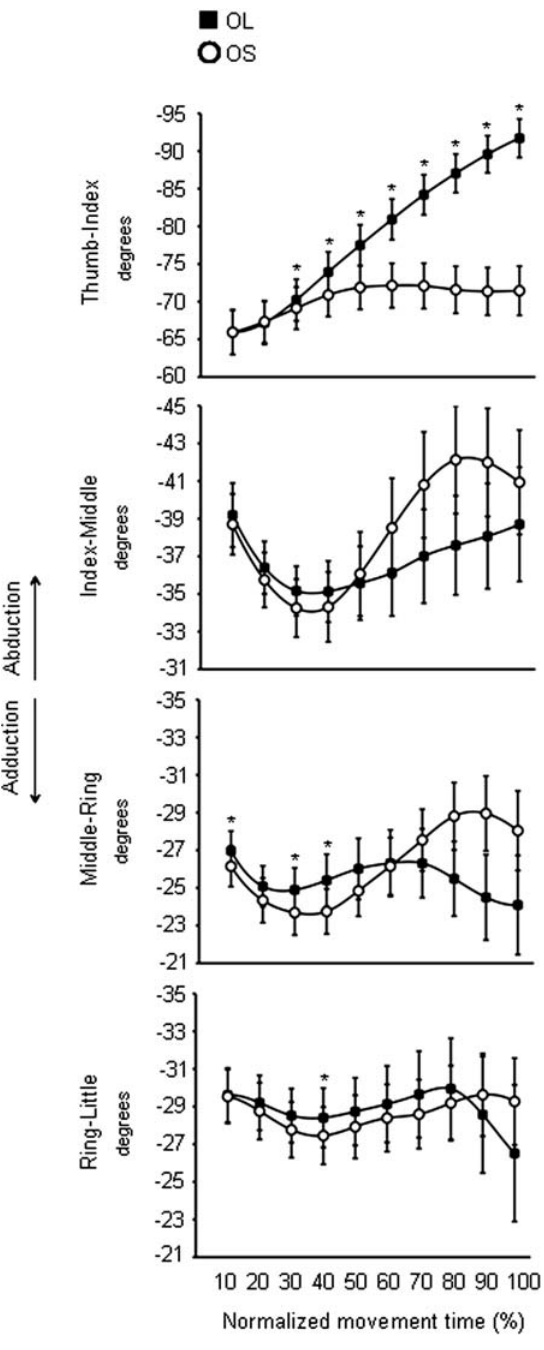
Figure 4. Time course of abduction angle between fingers during reaching in the absence of olfactory stimuli. Each trace corresponds to the average abduction angle for the ‘OL’ (black squares) and the ‘OS’ (white circles) conditions. Bars represent mean standard error. Increase in negative values correspond to bigger abduction (i.e., increase of digits’ angular distance). Asterisks indicate significant results ( p , .05) for the comparisons between the ‘OL’ and the ‘OS’ conditions at different epochs of normalized movement time. OL=Odourless air- Large target; OS=Odourless air-Small target.